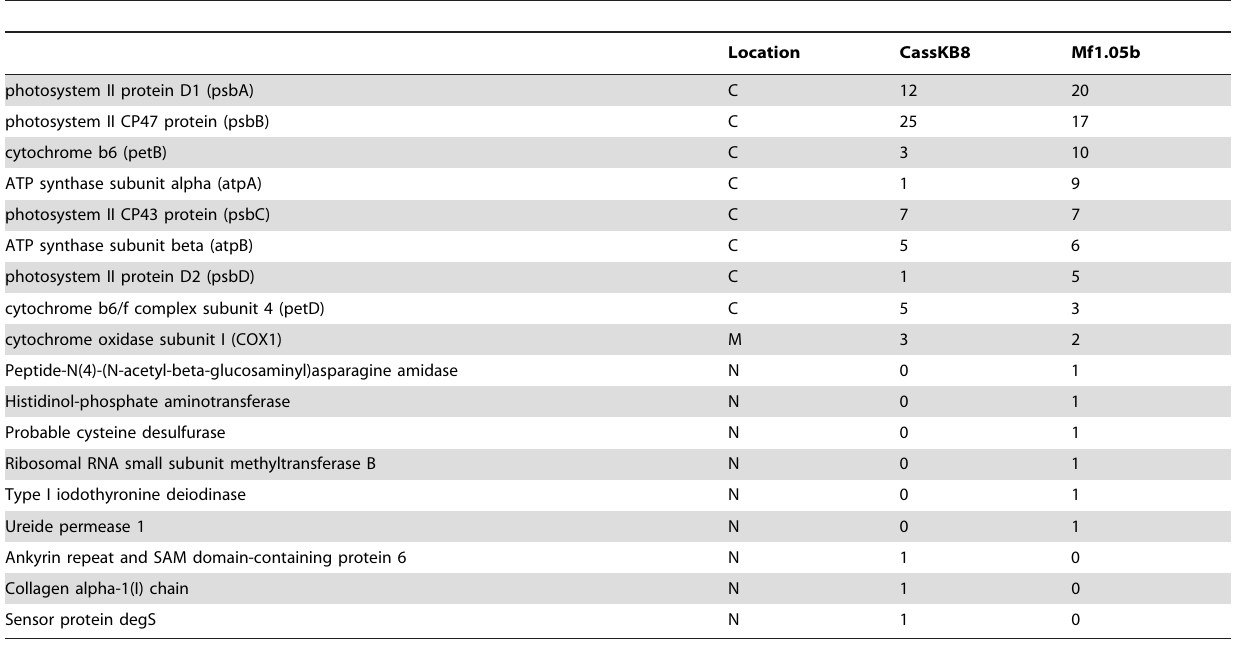
Table 4. Genes that are outliers in the correspondence analysis of codon usage (red points in Fig. 1).